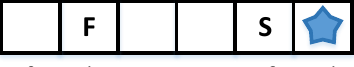
Figure 5. An example state of an 1D shepherding problem with n = 6. In this example, c f = 1 and c s = n −